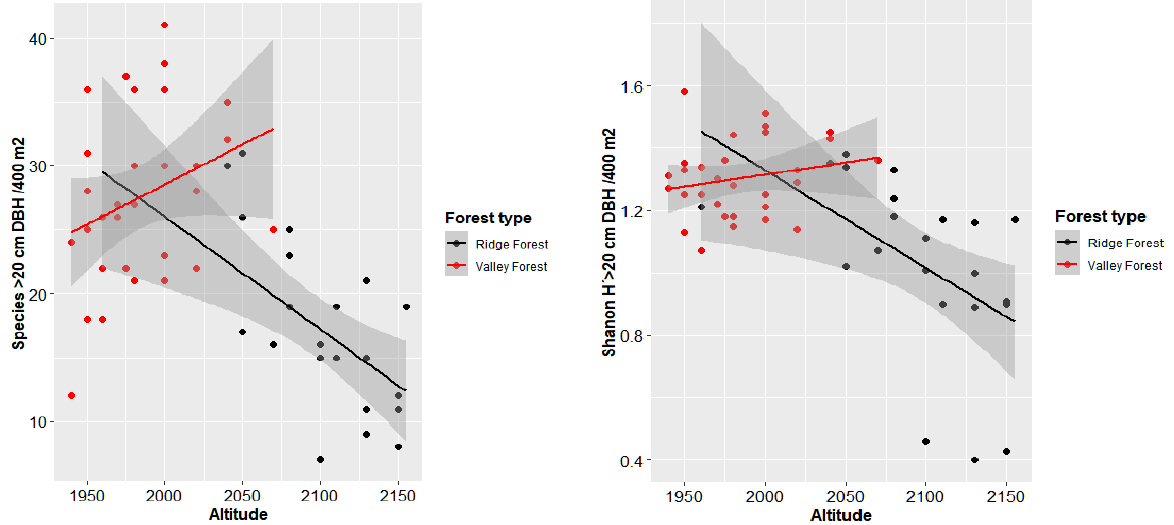
Figure 4. Changes of diversity and structure in altitudinal gradient. Significant correlations ( p < 0.05) are shown in regression line. For all tests, n = 52 plots.